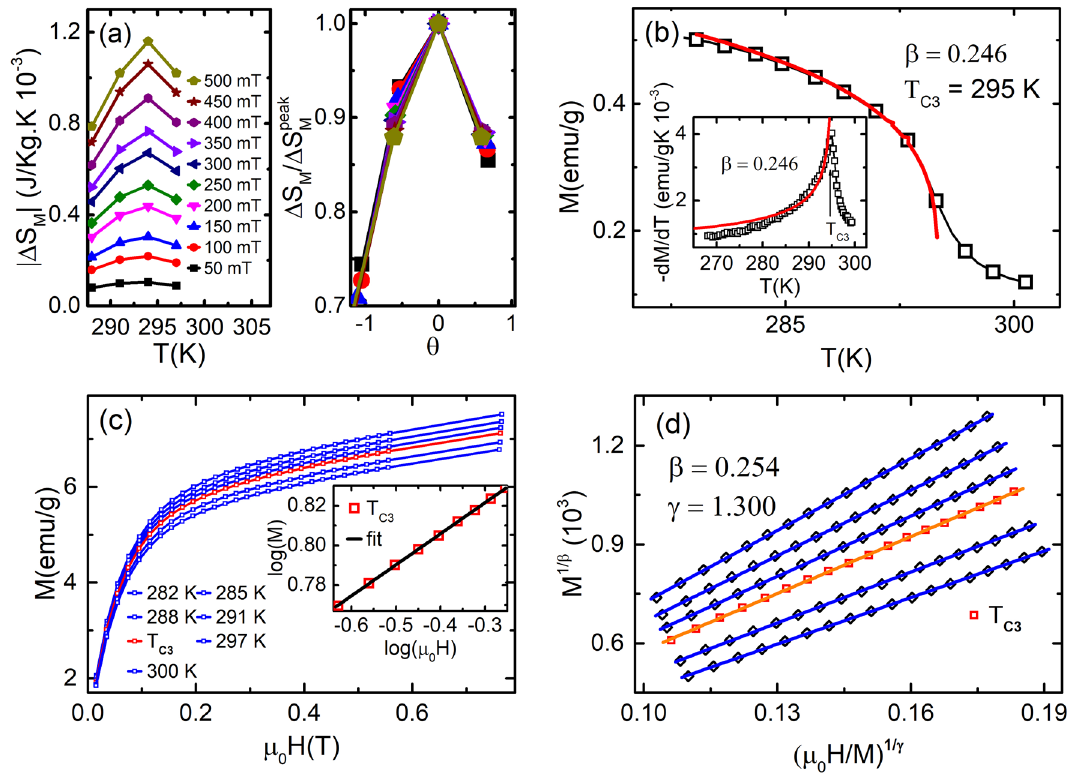
Figure 9. ( a ) Magnetic entropy change (cid:31) S M versus T at different applied magnetic fields varying from 50 to 500 mT, plotted using M-H curve of ( c ). This shows a continuous non-monotonic change of (cid:31) S M around T C 3 . Inset is normalized entropy change as a function of the rescaled temperature θ . All the curves almost collapse on a single universal curve for the second-order phase transition. ( b ) MT around T C 3 for temperature range 290–300 K. Inset is the derivative of MT which fitting with Eq. (8) gives the value of exponent β = 0.246. ( c ) The isothermal M-H for applied field from 0 to 0.75 T. Inset is the log – log plot of the isothermal M-H at T C 3 with fitting the log of Eq. (7), which gives the value of exponent δ = 6.4. ( d ) MAPs of BL-LSMO-0.3 shows